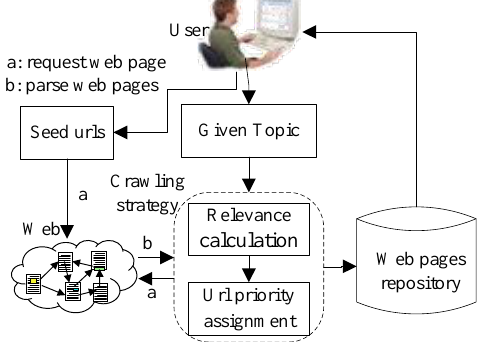
Figure 1. Workflow of the focused